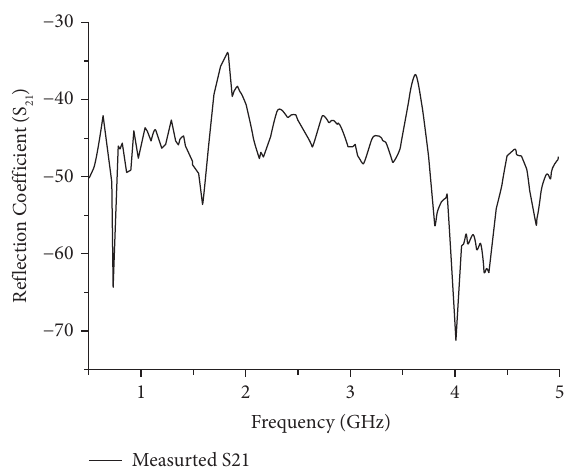
Figure 13: Measured S 21 returns loss of the proposed antenna.